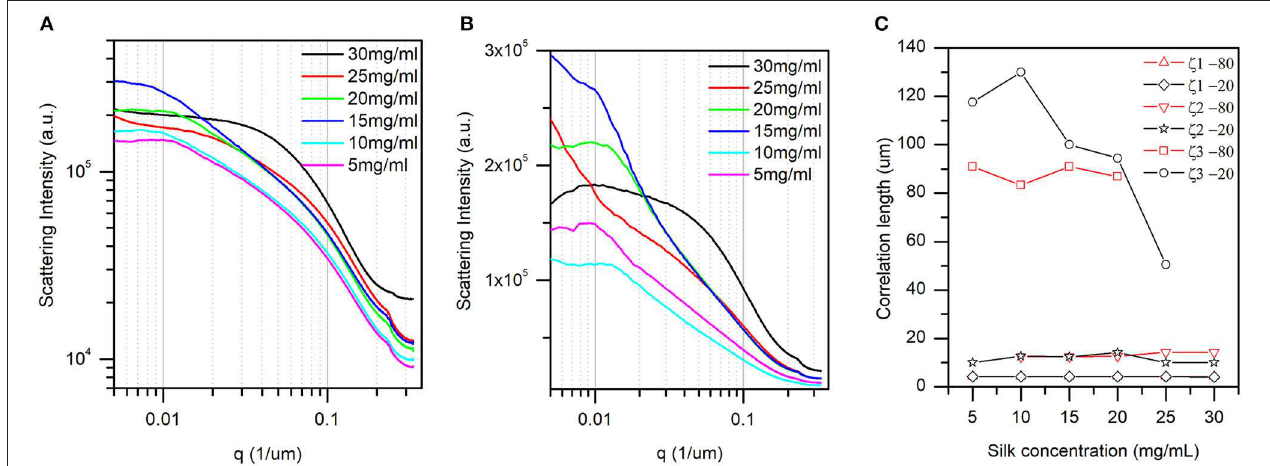
FIGURE 4 | The one-dimensional radial average of the 2D Fourier transform slices (see materials and methods for details). (A) At − 20 ◦ C, and (B) at − 80 ◦ C. The pairwise comparison is found in Figures S1–S6 . (C) Correlation lengths found at − 80 ◦ C and − 20 ◦ C and their dependence with silk concentration. Briefly, the peak positions identified in panel (A,B) are converted to representative dimensions (correlation lengths) in the sponge scaffolds (see text for details). Only correlation length 3 (x3) at − 20 ◦ C displayed an inverse linear dependence with silk concentration.